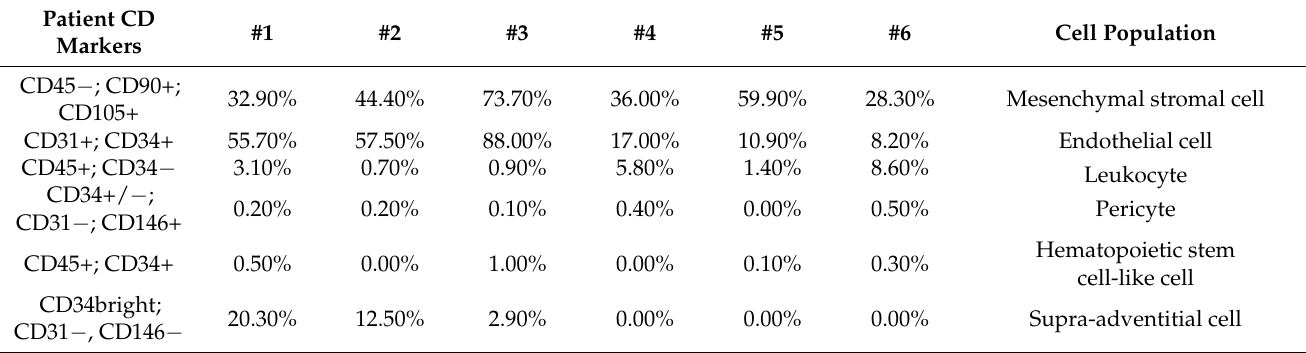
Table 2. Cell composition of tSVF based on CD marker